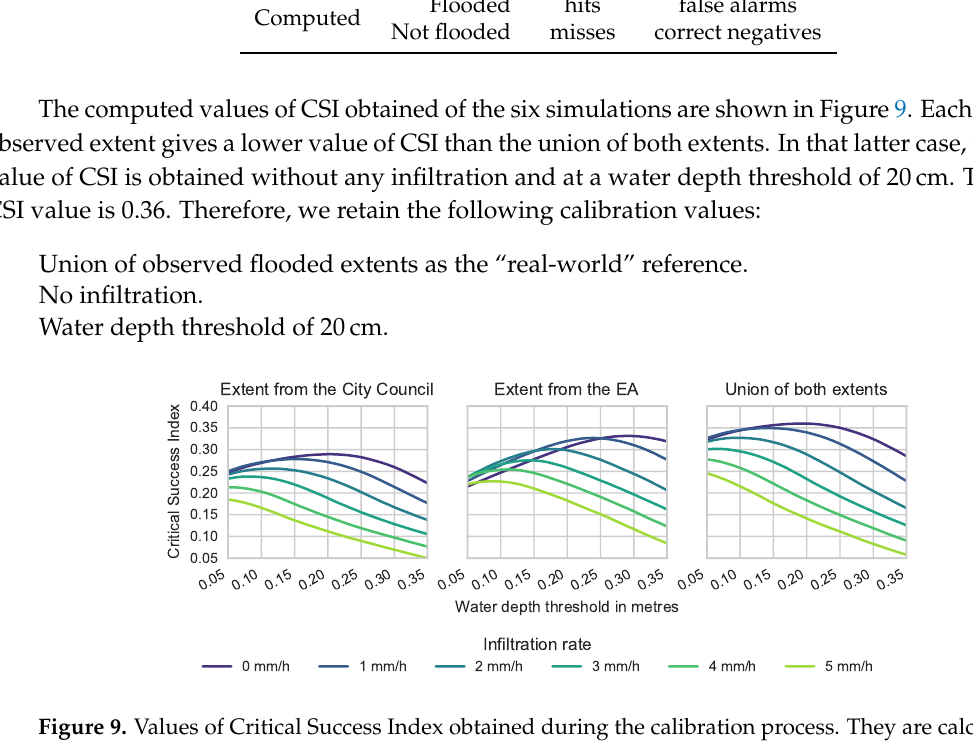
Figure 9. Values of Critical Success Index obtained during the calibration process. They are calculated using the maximal water depth maps obtained with uniform rainfall and a combination of infiltration values, water depth thresholds and observed